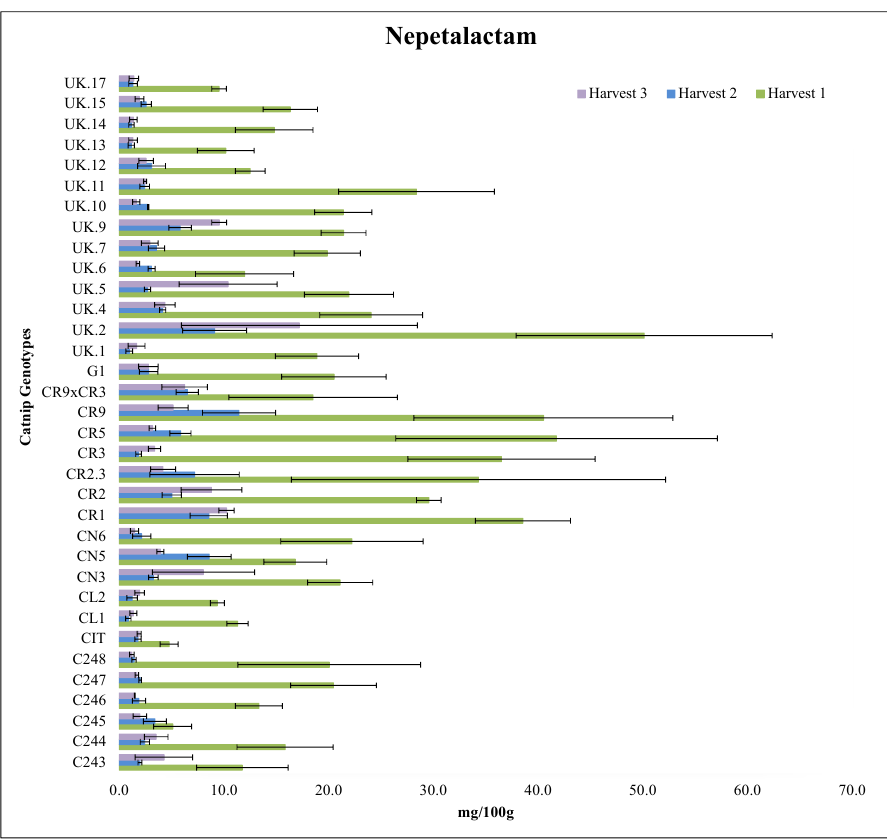
Figure 3. Nepetalactam (NT) content (mg/100g) of catnip genotypes at three different harvest times. Pittstown NJ, United States, 2017 and 2018. Error bars represent standard errors. Harvest 1 = July 2017, Harvest 2 = September 2017, Harvest 3 = June 2018. Detailed statistical analyses of the interaction effects are presented in the Supplementary material Table S3.